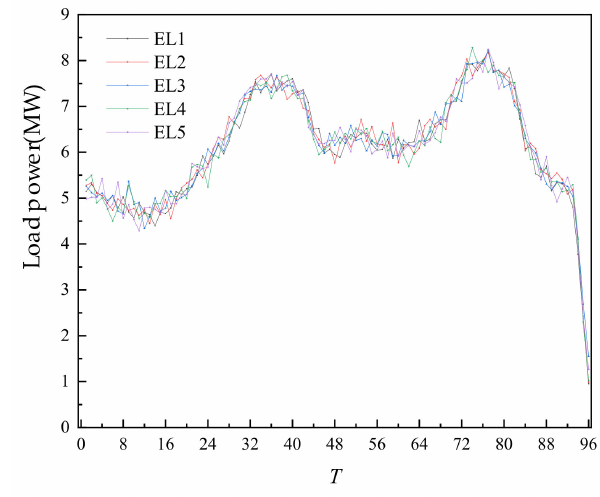
Figure 11. Intra-day forecast data of PV.